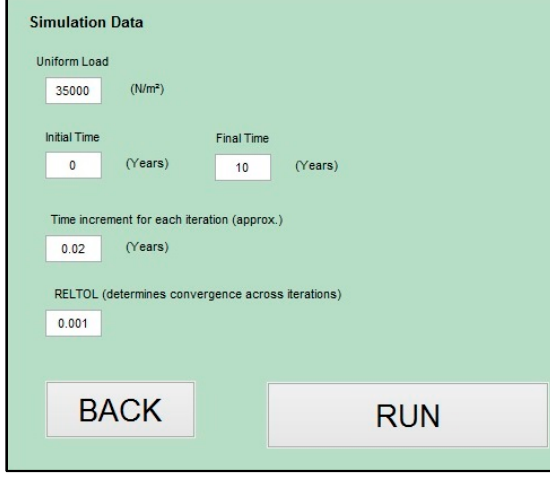
Figure 8. Third data entry screen.